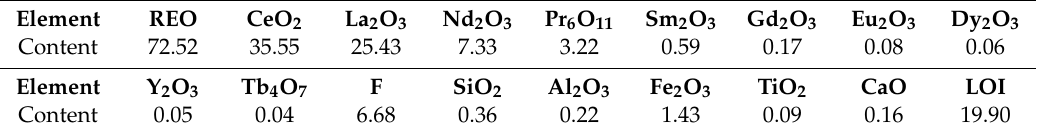
Table 1. Chemical compositions of the purified bastnaesite (mass fraction, wt